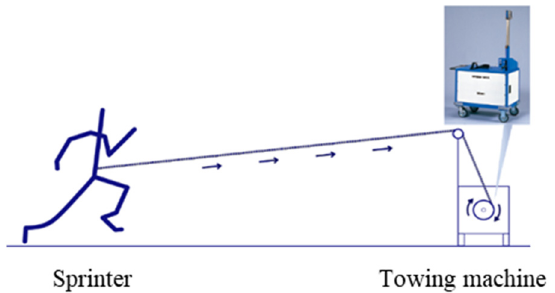
Figure 3. Supramaximal running in towing system. The towing machine comprises an electric motor, a powder clutch, and a dram to wind rope. A powder clutch works to stabilize the tension to pull the runner safely.